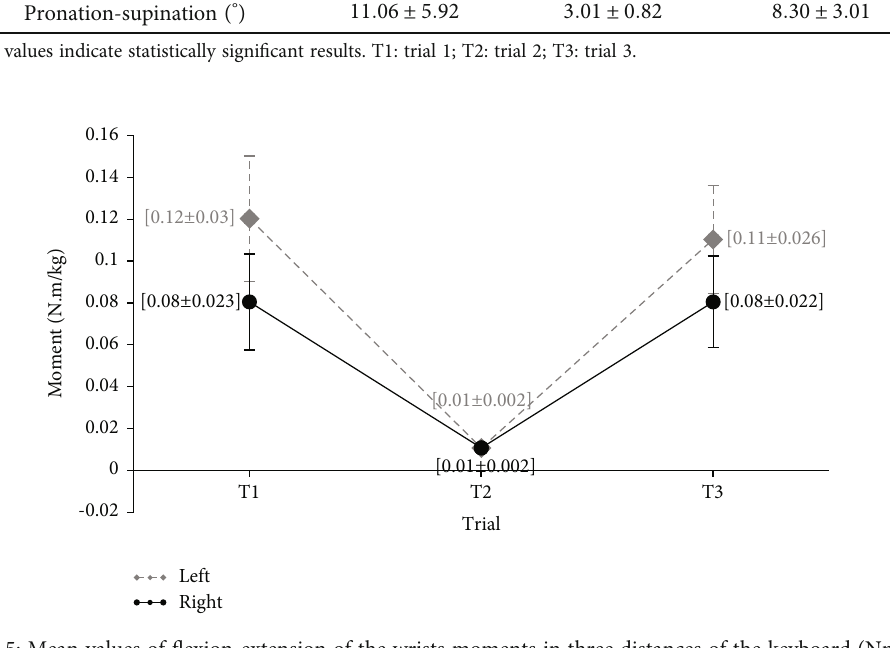
Figure 5: Mean values of fl exion-extension of the wrists moments in three distances of the keyboard (Nm/kg).